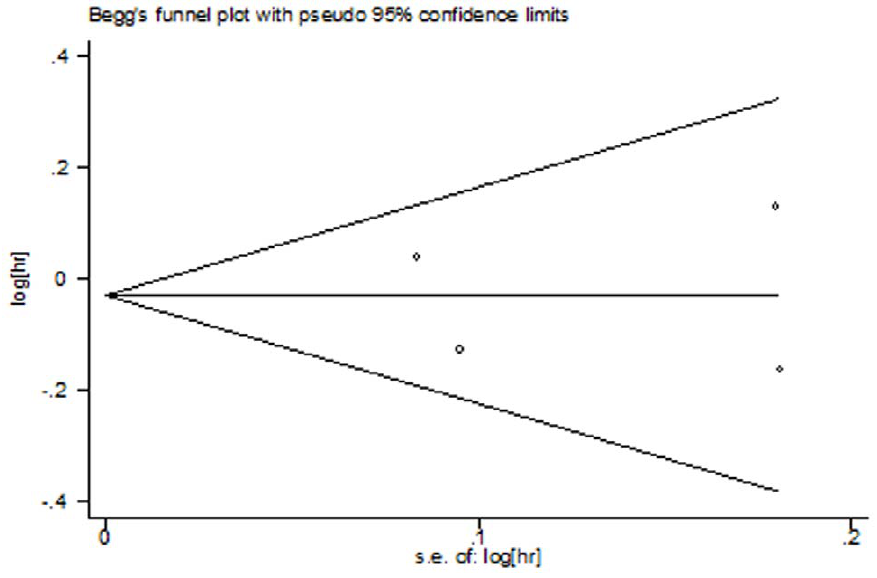
Figure 7. Funnel plot for publication bias test OS. The two oblique lines indicate the pseudo 95% confidence limits.